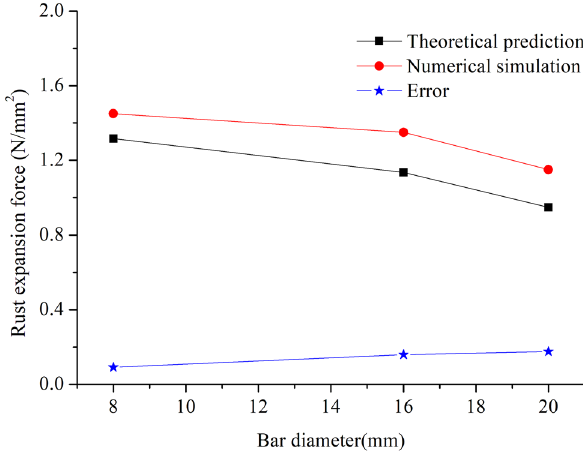
Figure 8. Relationship between rust expansion force and bar diameter.